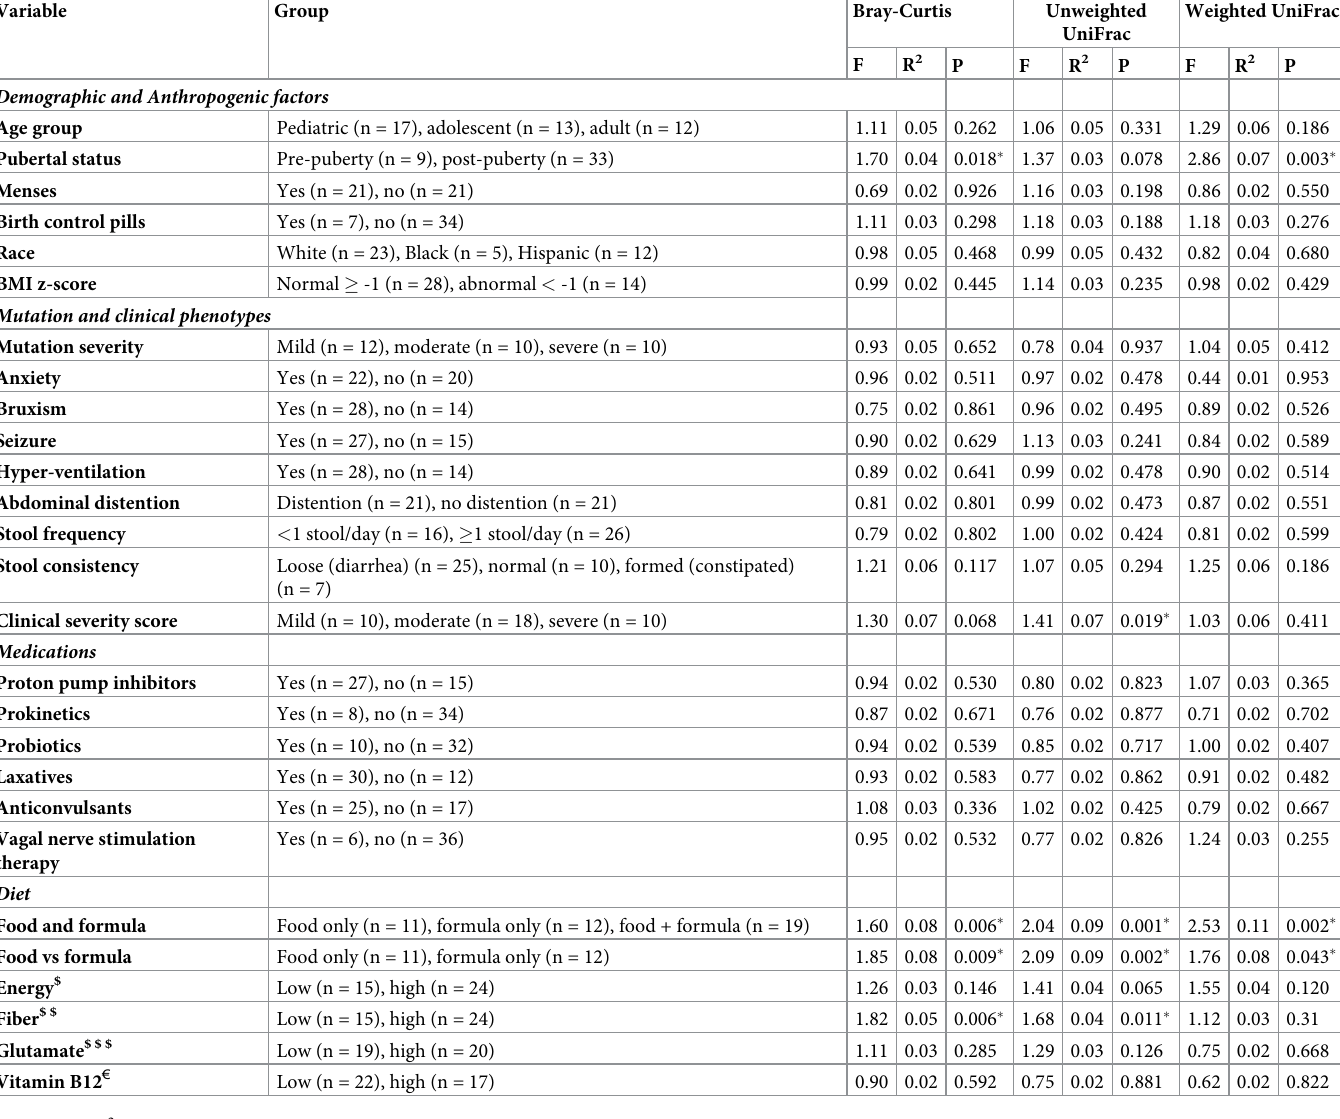
Table 3. Effects of various factors on the gut microbiome composition in RTT, as measured by PERMANOVA test of Bray-Curtis dissimilarity index and UniFrac distance matrices.